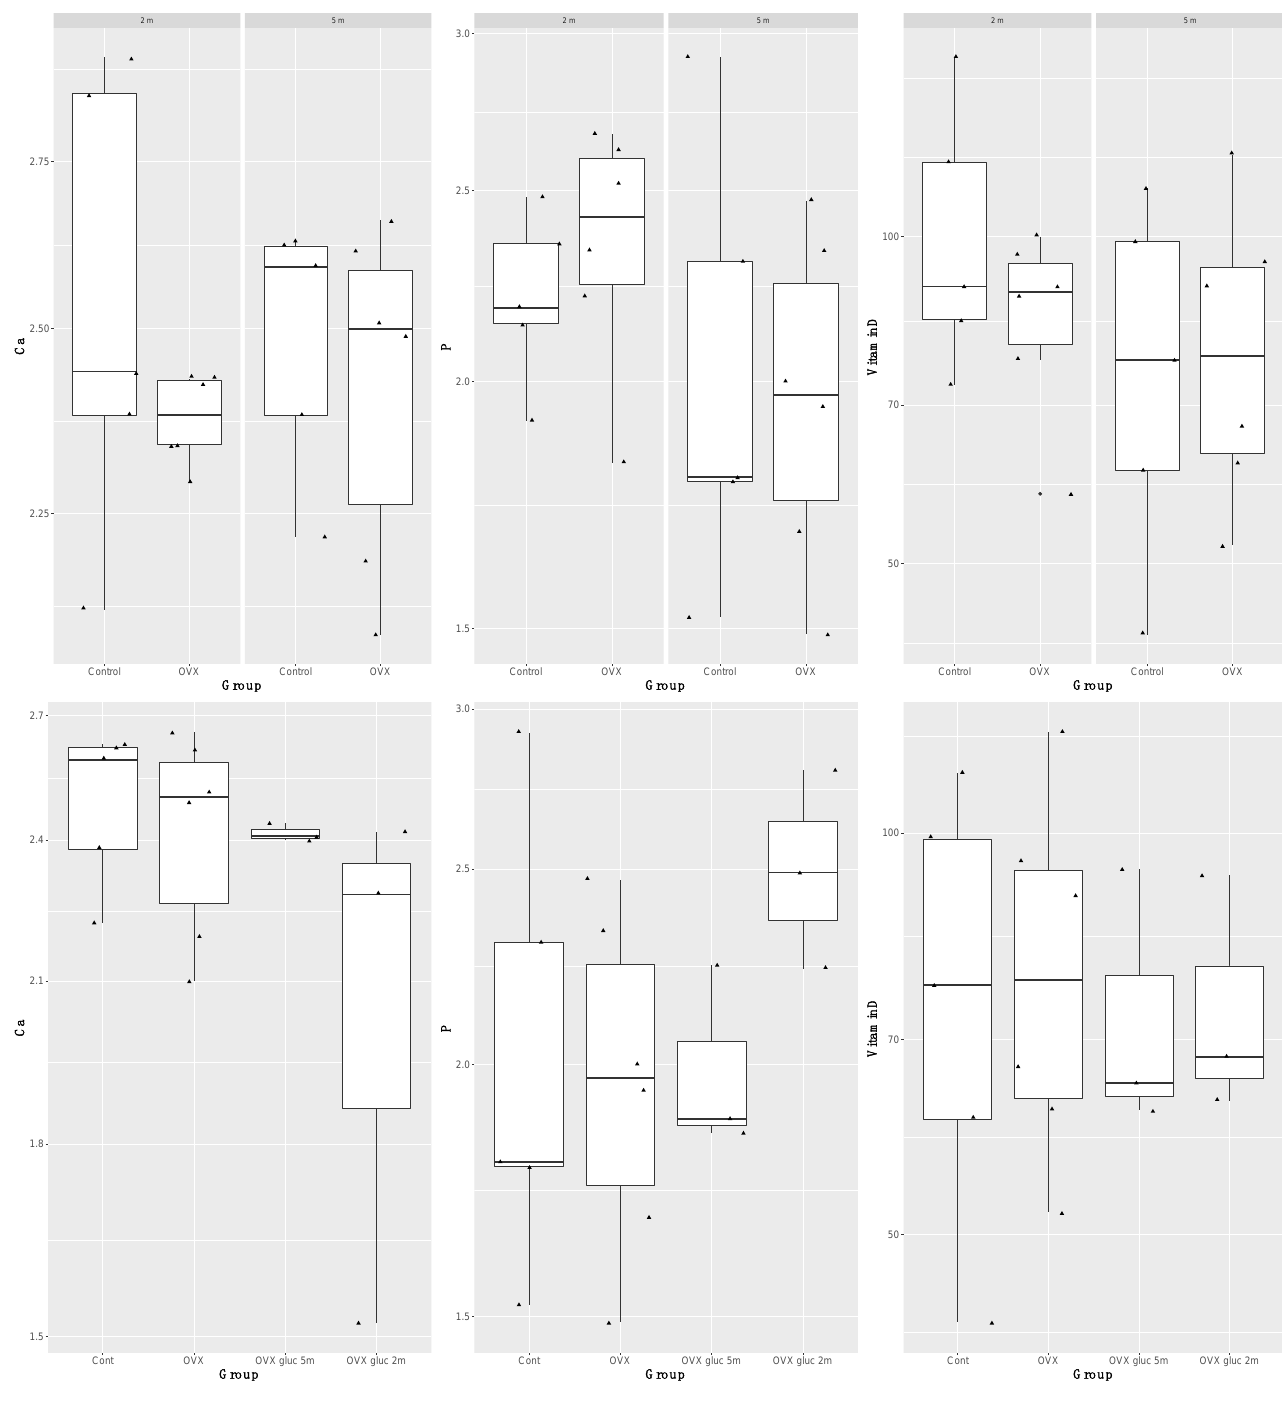
Figure 1. Boxplots of serum calcium (Ca), phosphorus (P) and 25-hydroxyvitamin D (Vitamin D) concentrations in control and ovariectomized (OVX) sheep euthanized at 2 months and 5 months of the trial (top line of boxplots), and in control (Cont), ovariectomized (OVX), OVX and glucocorticoids for 5 months, and OVX and glucocorticoids for 2 months followed by 3 months recovery, with euthanasia at 5 months.